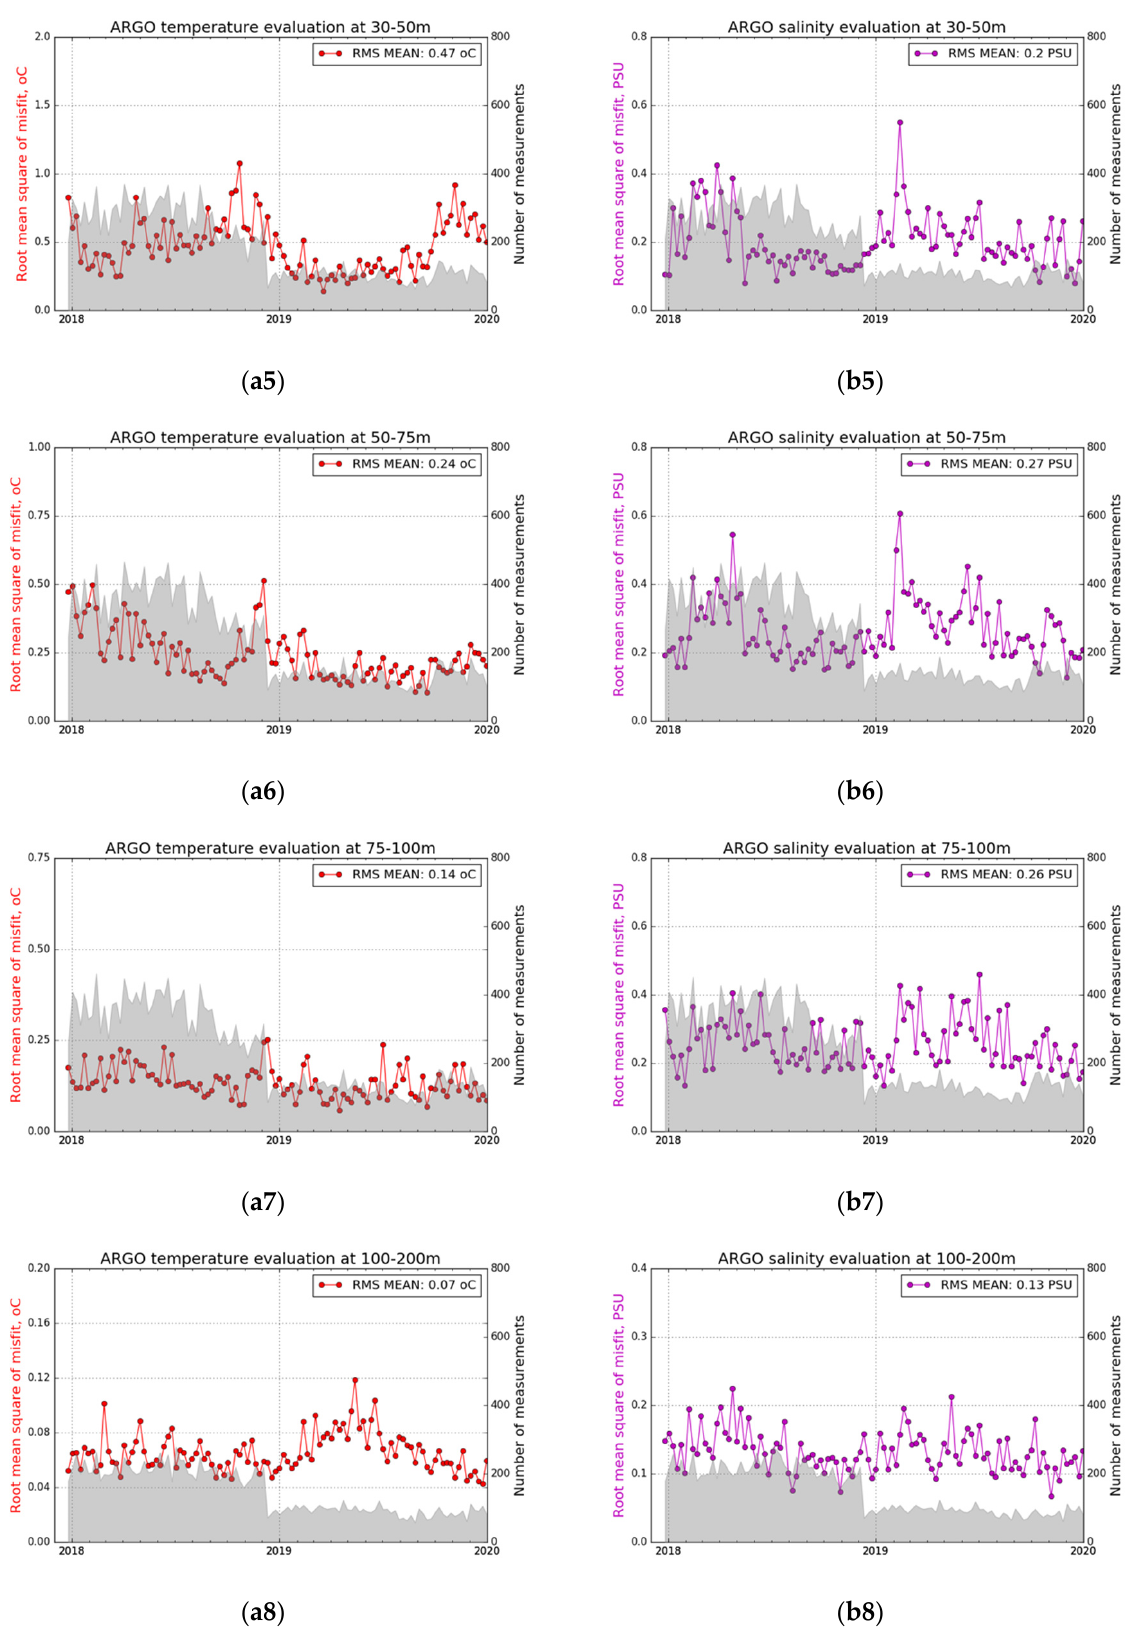
Figure 5. RMSE timeseries between BSFS analysis fields and ARGO observations for temperature ( a1 – a8 ) (expressed in °C) and salinity (expressed in PSU) ( b1 – b8 ). The reference layer as considered for the evaluation is written on the top of each panel.